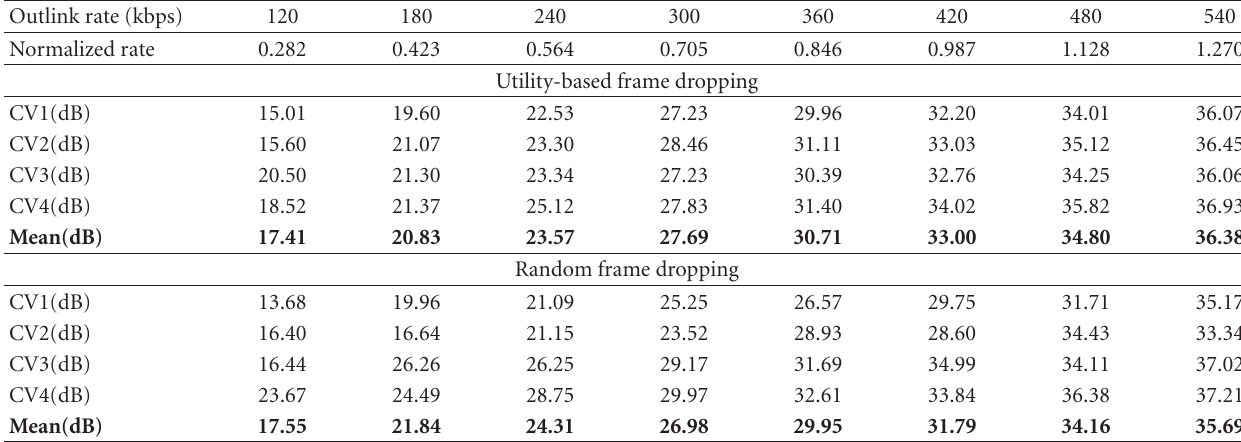
Table 4: Comparison of utility-based dropping and random dropping.